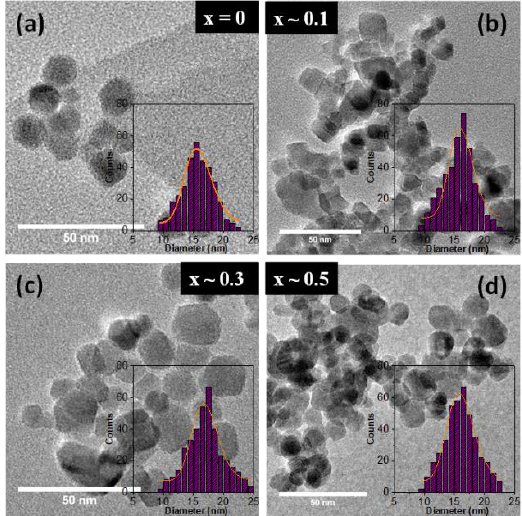
Figure 1. TEM images of Zn x Fe 3−x O 4 MNPs with different stoichiometry ( a ) x ~ 0, ( b ) x ~ 0.1 ( c ) x ~ 0.3 and ( d ) x ~ 0.5. Insets represent size distribution histograms of Zn x Fe 3−x O 4 MNPs fitted to a log-normal distribution (orange lines). Table 1. Structural properties of Zn x Fe 3−x O 4 MNPs.